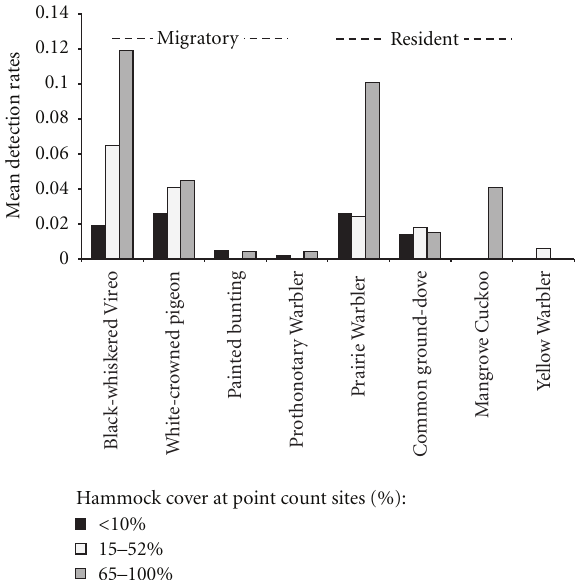
Figure 2: Mean frequency (presence) detection rates at point count sites categorized by percent hammock cover for migratory and resident species designated as species of conservation concern by the U.S. Fish and Wildlife Service